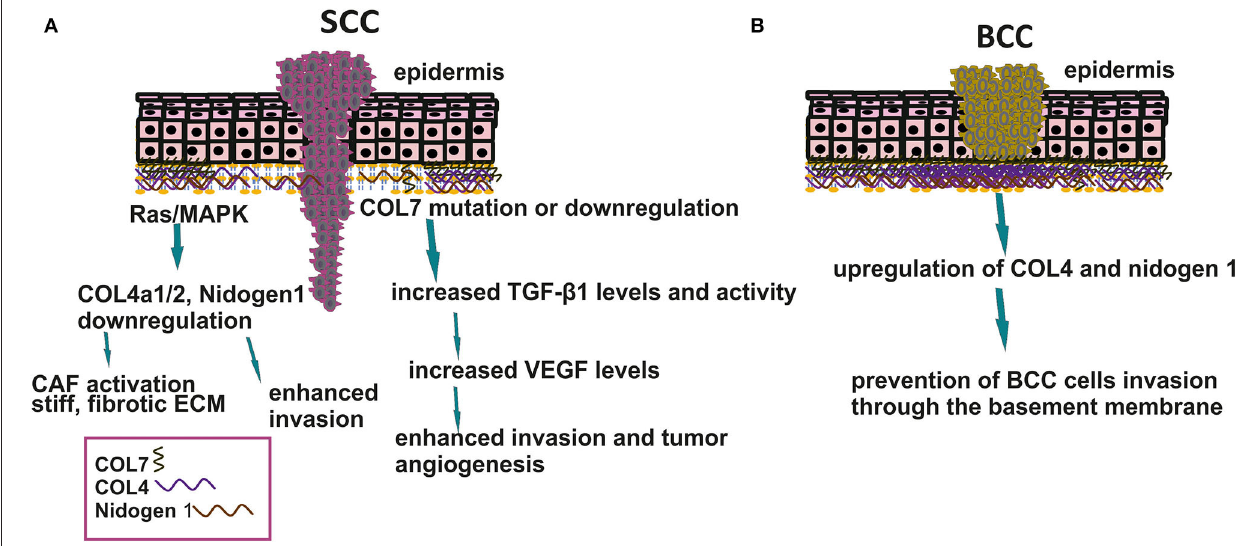
FIGURE 1 | Basement membrane organization in SCC and BCC. (A) Downregulation in BM components enhances SCC cell invasion to the stroma affects matrix stiffness and tumor angiogenesis. (B) Upregulation of COL4 and nidogen 1 prevents BCC cells to